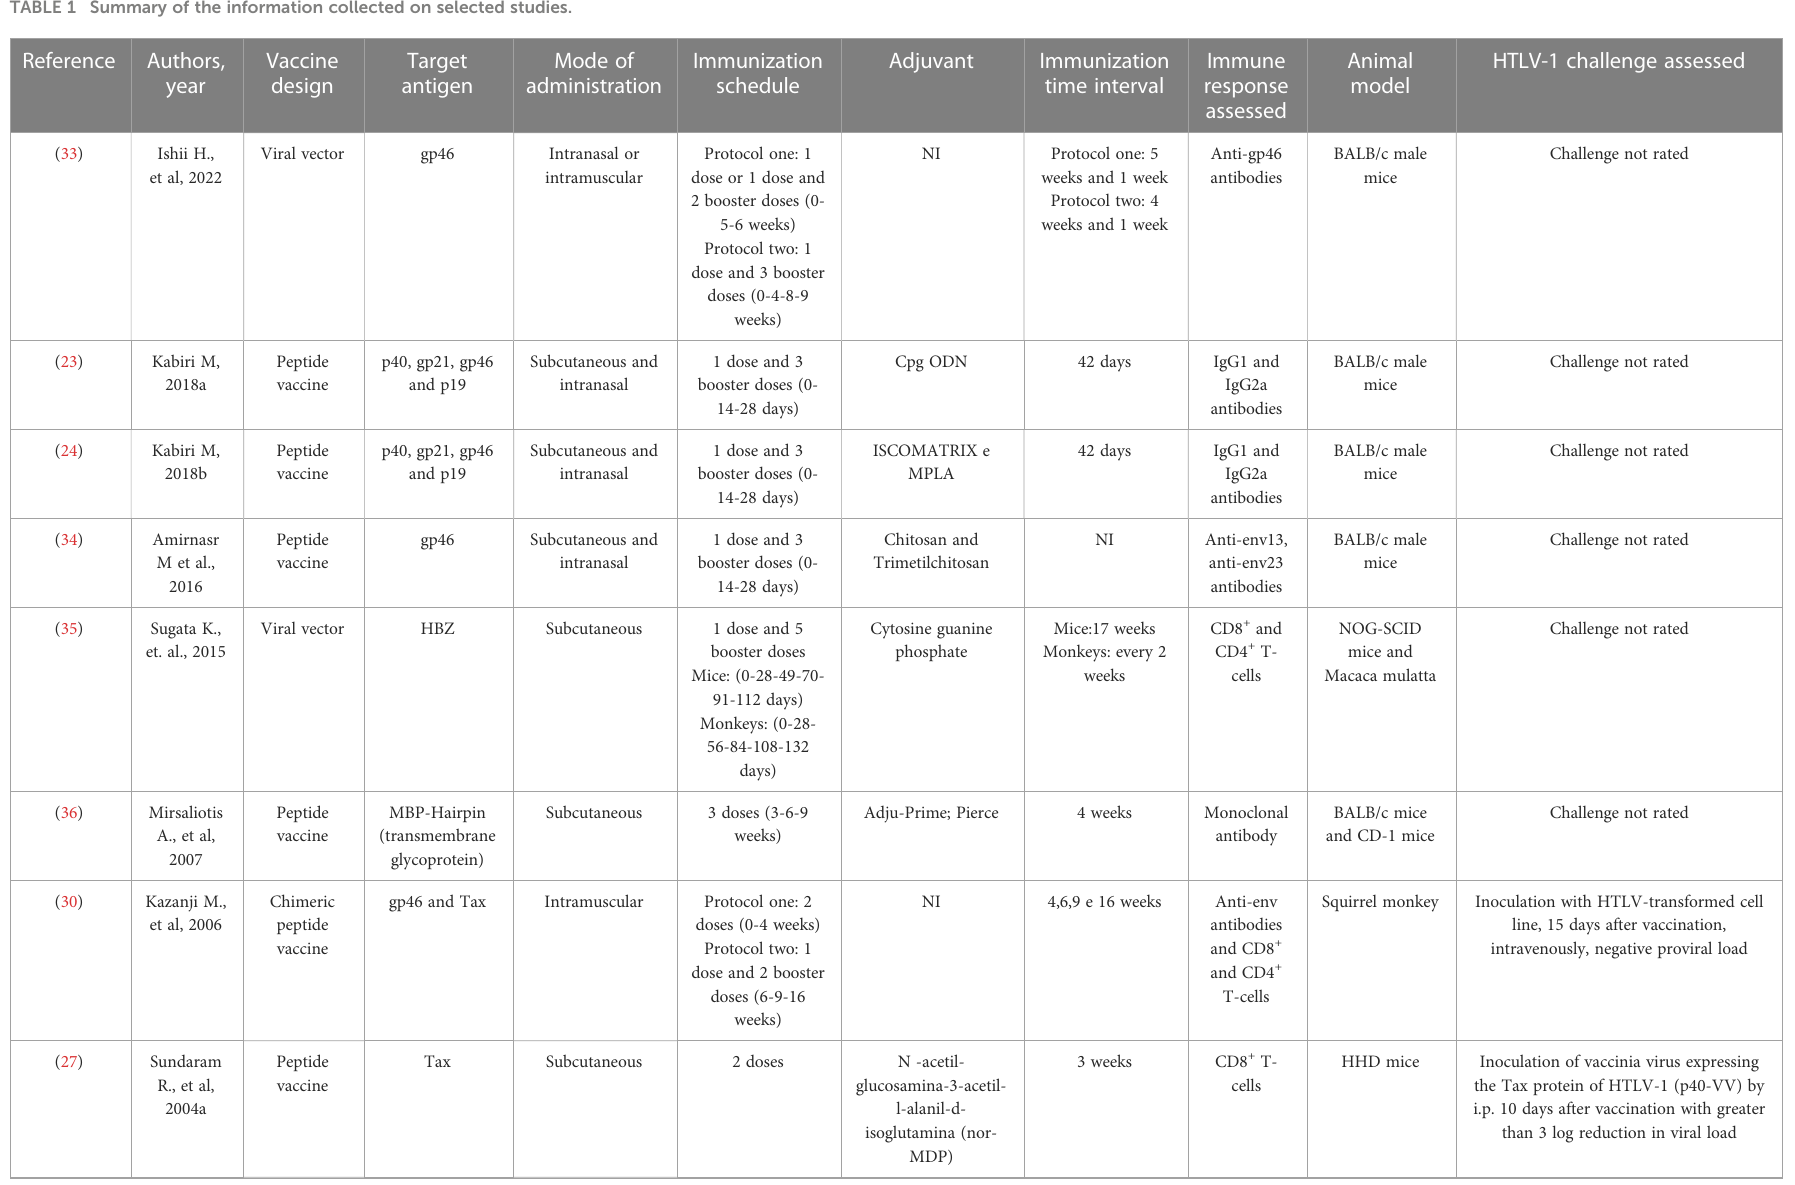
TABLE 1 Summary of the information collected on selected studies.